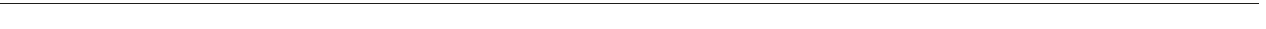
Fig. 5 Survival genetic interactions between NUDIX genes. a Genetic interactions between NUDIX genes in the four cell lines, CCD841, and cancer cell lines A549, MCF7, and SW480. A genetic interaction was assigned to pairs of genes based on deviation of cell viability of the double knockdown from cell viability of the double knockdown that would be expected if the genes were not interacting. The expected viability was determined with a multiplicative null function. The interaction maps include negative (or aggravating) interactions, as well as positive (or alleviating interactions). Alleviating interactions, shown in blue, suggest that certain NUDIX product operate in concert or in series within the same pathway. b Statistically signi fi cant genetic interactions between NUDIX genes in the four cell lines, CCD841, and cancer cell lines A549, MCF7, and SW480 are visualized using networks. For each gene pair, the genetic interaction was assessed by using a two-tailed Z -test α = 0.1 (dotted line and solid line) or α = 0.05 (solid line only). Shown are genetic interactions whose values are signi fi cantly larger (indicating alleviating interaction) or signi fi cantly smaller (indicating aggravating interaction) than values in the 90% (dotted line and solid line), or 95% (solid line only) of interaction density in the respective cell line. c The overlap of signi fi cant genetic interactions from b ( α = 0.05) is shown using Venn diagrams. The size of each circle in the diagram is proportional to the number of signi fi cant genetic interactions in the respective cell line. d Scatter plot indicating the correlation between each epistasis scores corresponding to each cell line, Spearman ’ s correlation indicates high similarity. e Box plots comparing log2 mRNA expression in cancer vs normal tissues, and epistasis score. Five epistasis score bins were used to classify the NUDIX genetic interactions. The list of each NUDIX interaction can be found in Supplementary Data